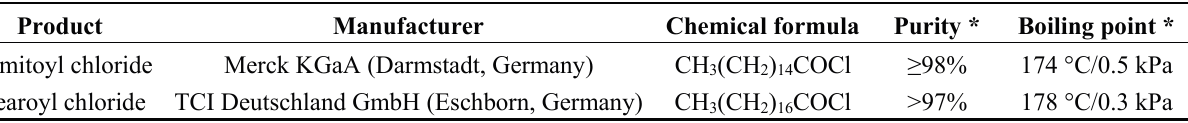
Table 3. Fatty acid chlorides, their suppliers and important